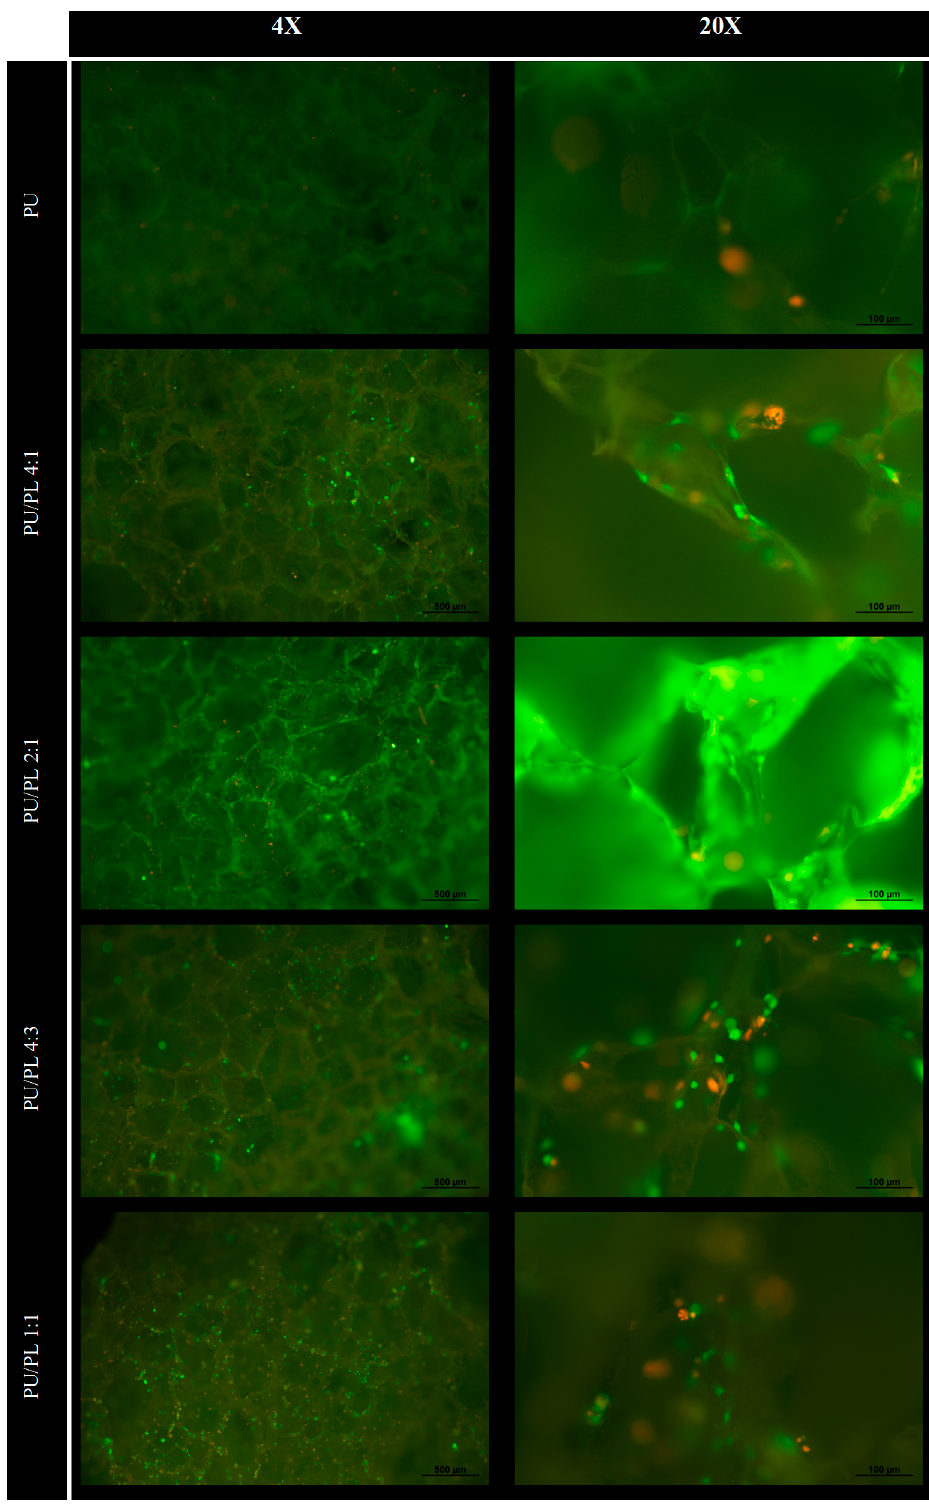
Figure 2. 7F2 osteoblast cultured on polyurethane composite fillers with different composition under LIVE/DEAD stain, 3 days after cell seeding.